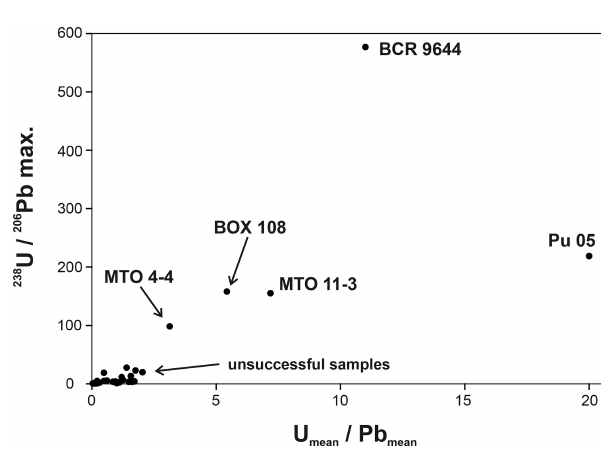
Figure 2. Diagram showing U mean content toPb mean content vs. max- imum value on the 238 U / 206 Pb axis. The successfully dated sam- ples have a distinctively higher U / Pb